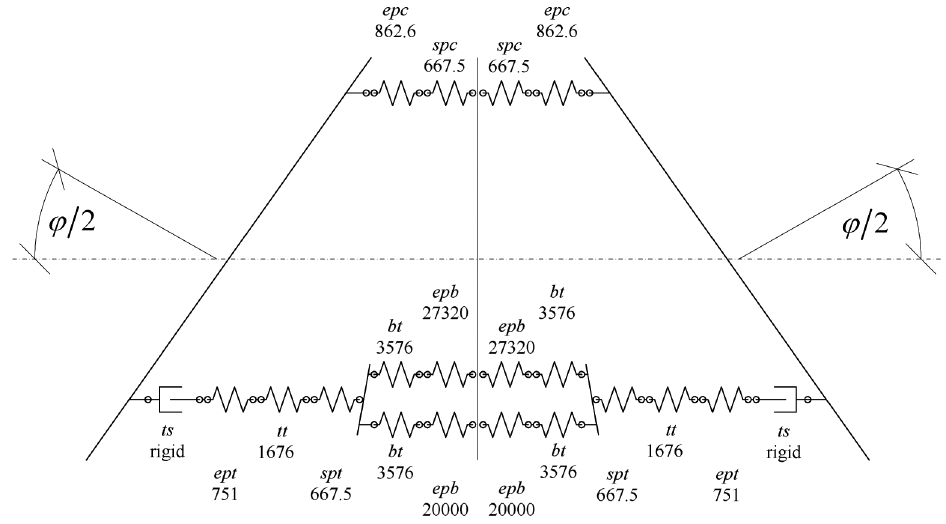
Fig. 7. Graphic depiction of basic component values (values are in